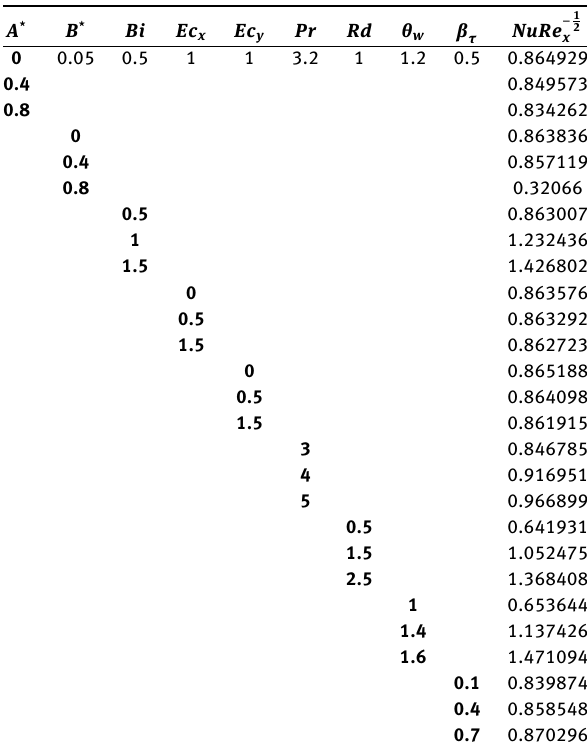
Table 2: Values of Nusselt number for various existing